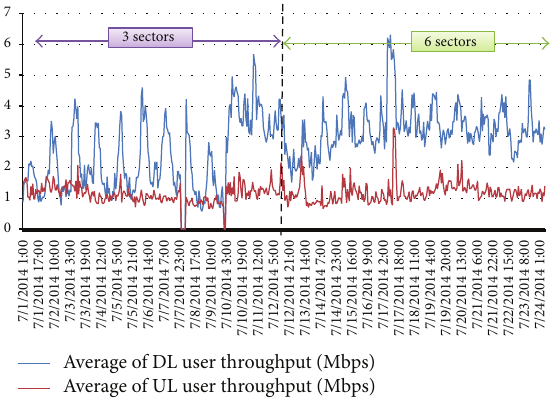
Figure 8: The uplink and downlink user throughput in Mbps before and after the 6-sector integration.